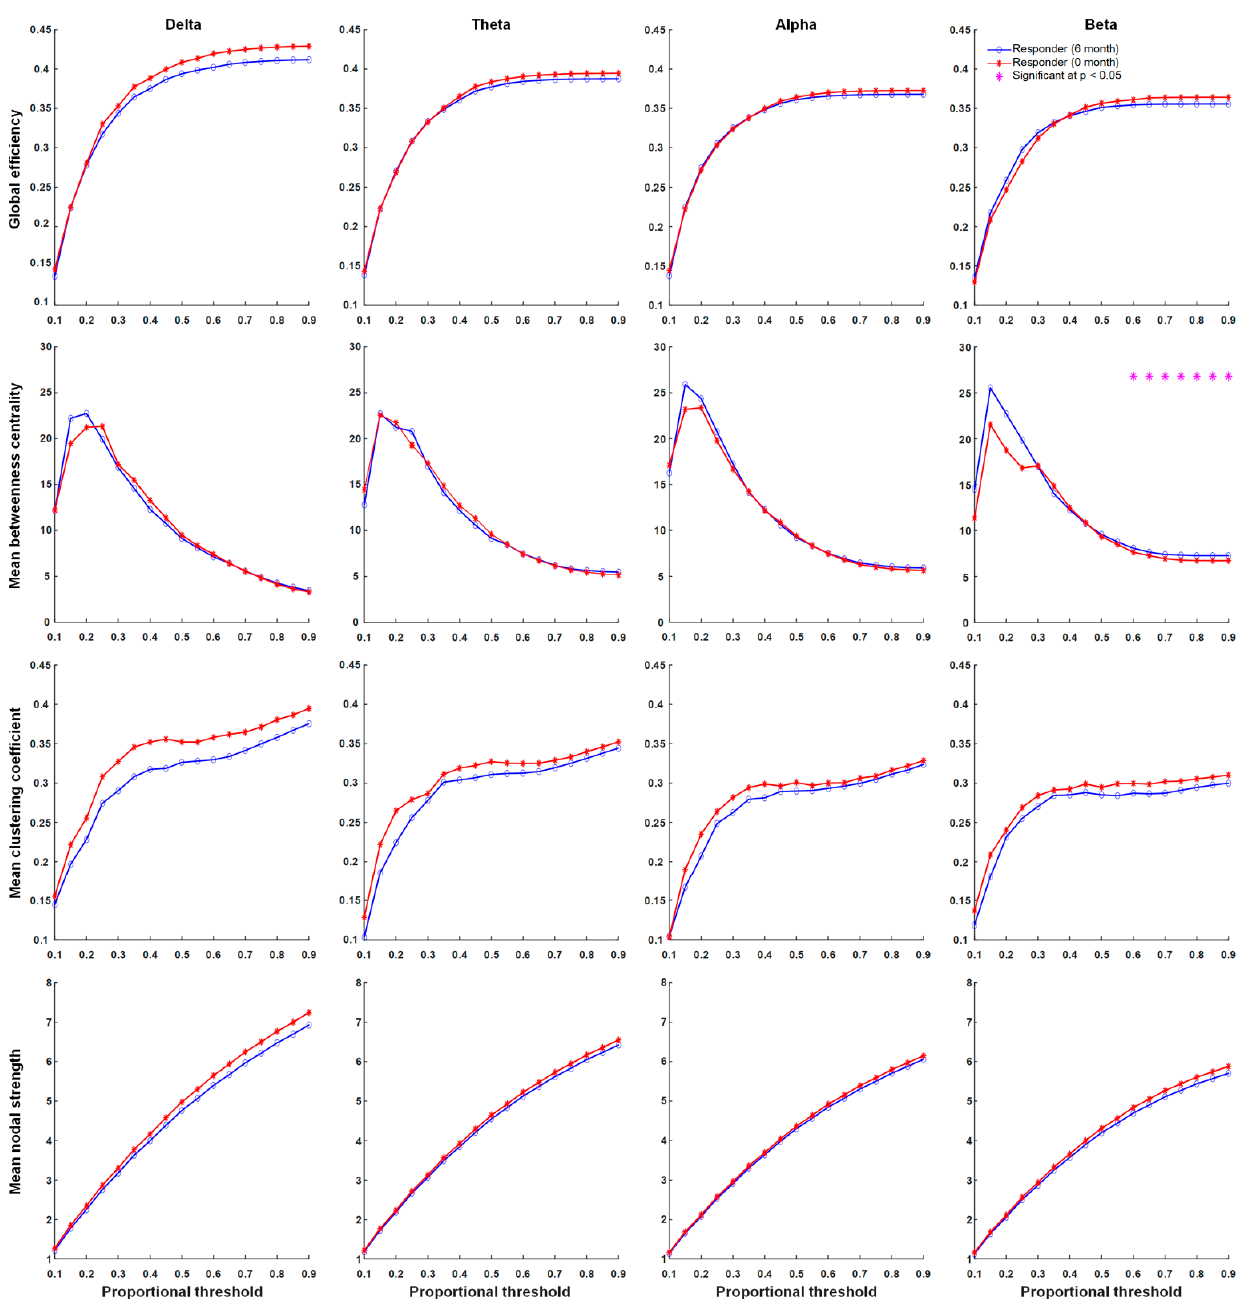
Figure 3. Graph theory-based analyses between before KDT and after six months of KDT for responders show global efficiency, mean clustering coefficient, mean nodal strength, and mean betweenness centrality in delta, theta, alpha, and beta frequency bands. The results revealed significant increases in the network properties of mean betweenness centrality in the beta frequency band after six months of KDT. Asterisks denote statistically significant differences (* p < 0.05). (KDT: ketogenic diet therapy.)